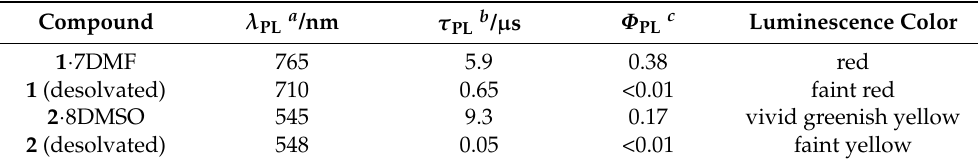
Table 3. Solid-state photophysical data (298 K) of paddlewheel clusters in the solvated ( 1 · 7DMF and 2 · 8DMSO) and desolvated ( 1 and 2 ) forms ( λ ex = 365 nm). Compound λ PL a /nm τ PL b / µ s Φ PL c Luminescence Color 1 · 7DMF 765 5.9 0.38 red 710 0.65 <0.01 faint